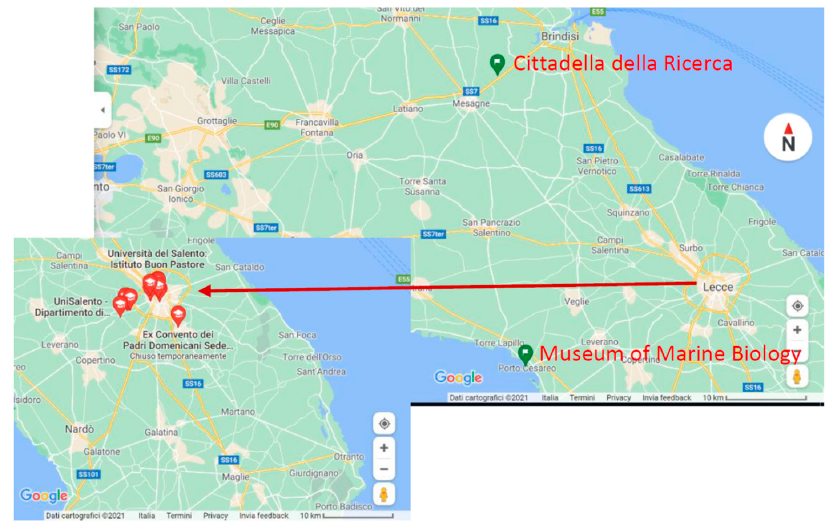
Figure 1. Distribution of the buildings monitored in the survey (Map data ©2021 Google).